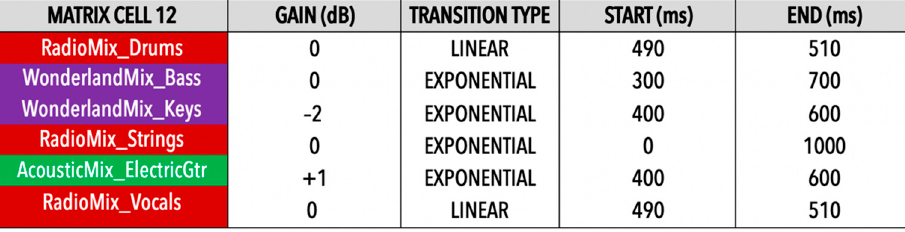
Figure 9. An example of gain and fade settings for a single cell (cell 12 of the matrix in Figure 7).